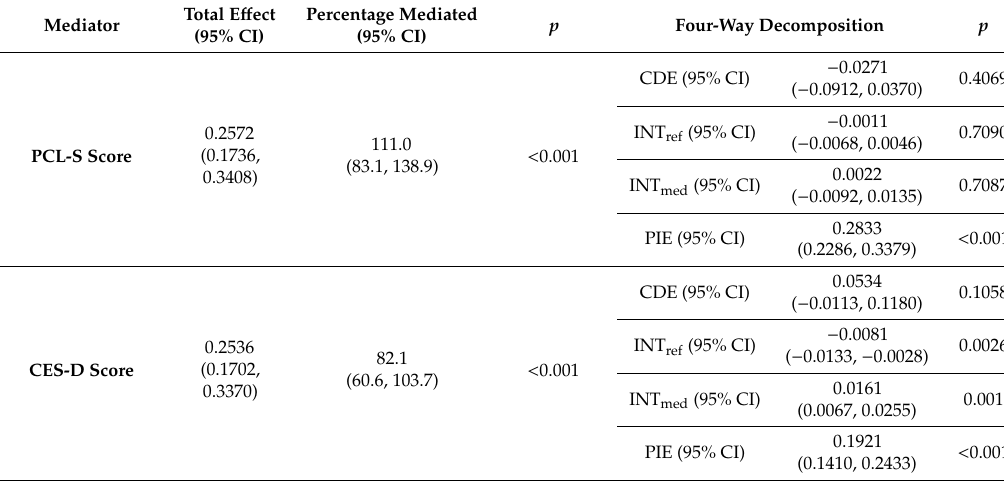
Table 3. Mediators of the association between WTC exposure level and CFI score in FDNY rescue / recovery workers.